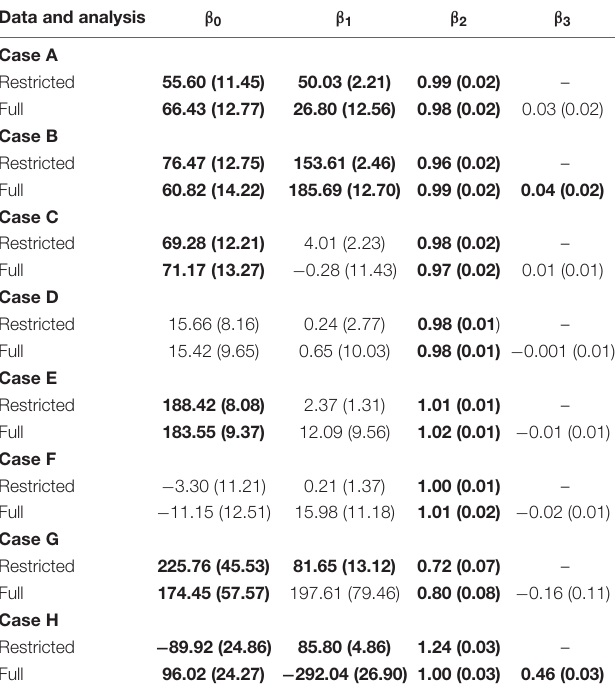
TABLE 3 | Model comparison analysis fixed effect